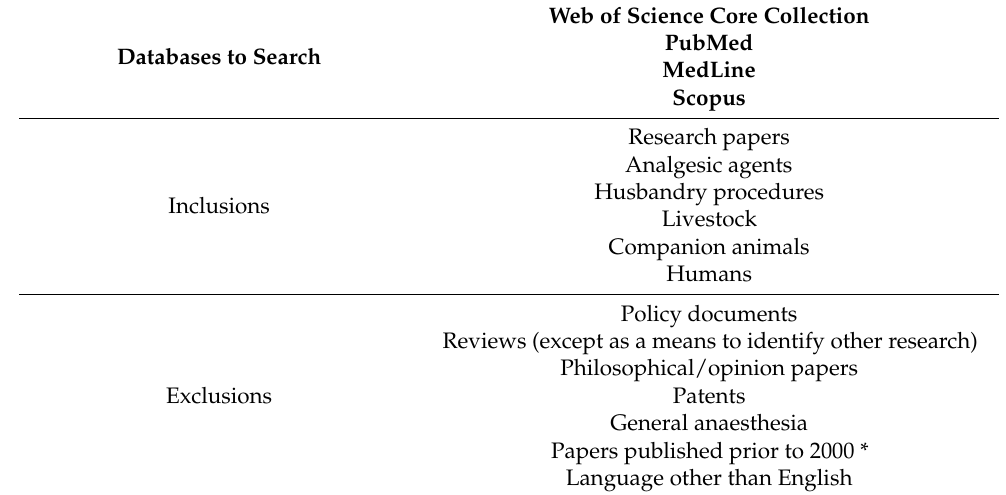
Table 1. Literature Search Criteria.